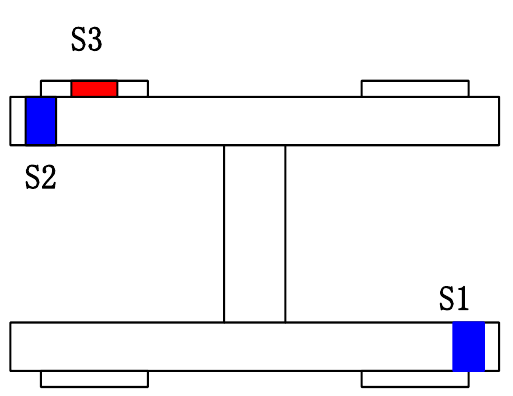
Figure 5. Installation locations of the accelerometers. S1, S2: Accelerometer on the bogie frame; S3: Accelerometer on the axle box.